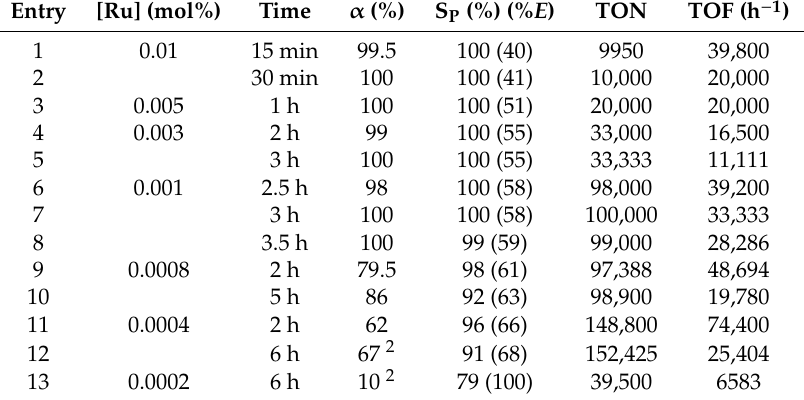
Table 3. The e ff ectiveness of [RuClH(CO)(PPh 3 ) 3 ] in the solvent-free isomerization of the AHP-free 4-allyloxybutan-1-ol to (Z)- and ( E )-4-(1-propenyloxy)butan-1-ol: the e ff ect of the [Ru] loadings 1